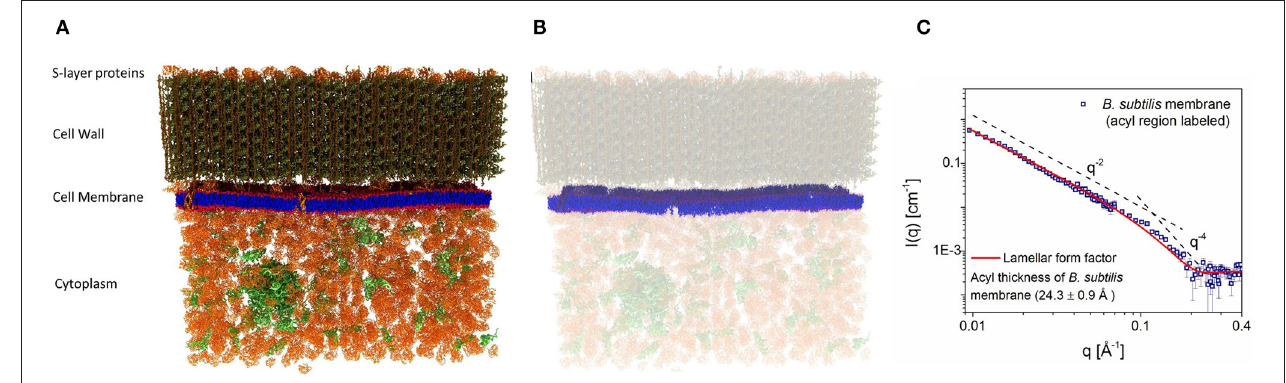
FIGURE 3 | (A) Schematics of the wild type Bacillus subtilis cell wall, membrane, and cytoplasm. (B) Bacteria grown in deuterated media, replacing its protium for deuterium, were fed protiated fatty acids to introduce neutron contrast. Under these conditions, the protium-labeled membrane is the only structure visible to neutrons when the bacteria were immersed in 85% heavy water (D 2 O). (C) Small angle neutron scattering (SANS) data from the system in B were fitted using a lamellar form factor, resulting in an average hydrophobic membrane thickness of 24.3 ± 0.9 Å. Figure adapted from Nickels et al.